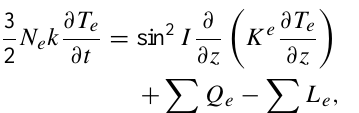
Fig.9. Variation of observed electron temperature (all data) with the observed electron density in the corresponding seasons.